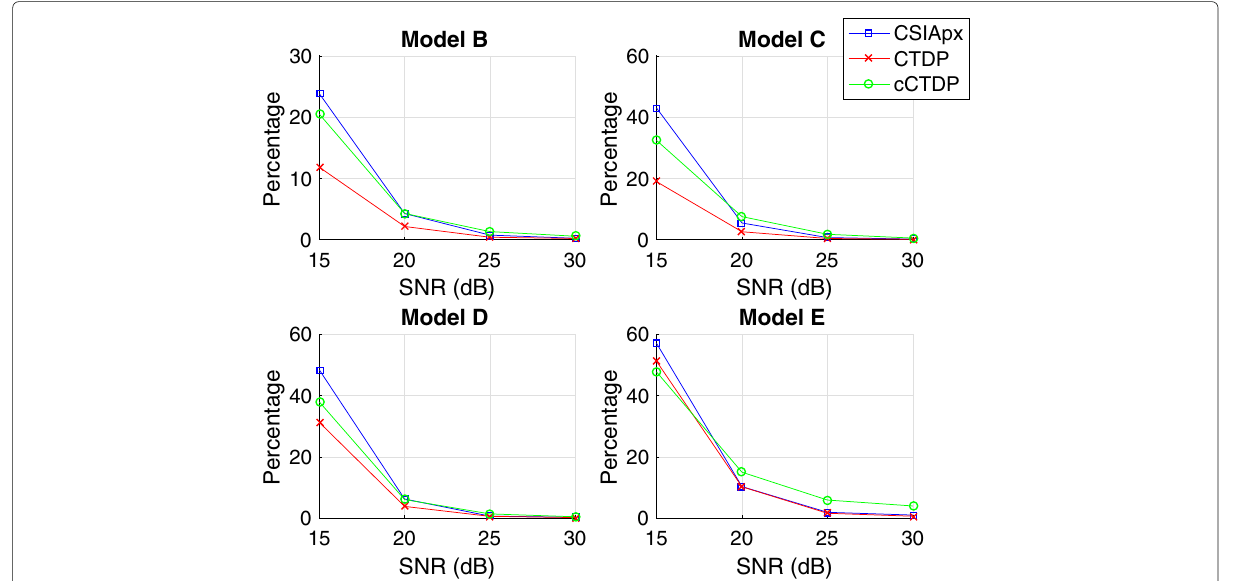
Fig. 11 MU-MIMO rate difference with model data. The percentage of cases where the normalized rate differences are above 3% or lower than − 3% is shown when running CSIApx versus CTDP versus CCTDP on the synthesized CSI